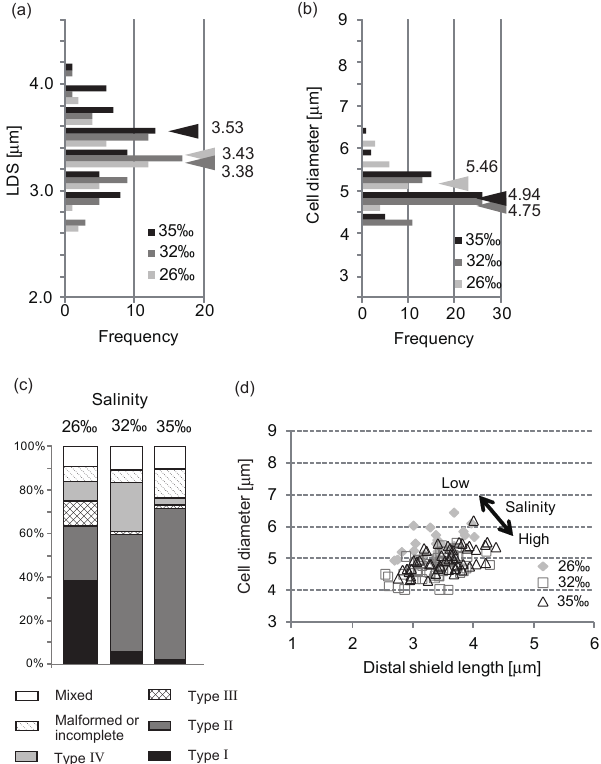
Figure 8. Influence of salinity on the morphometric parameters of E. huxleyi strain MR70N. (a) LDS; (b) cell diameter; (c) propor- Figure 7. Saruwatari et al. tion of coccolithophore morphotypes; (d) relationship between cell diameter and LDS.